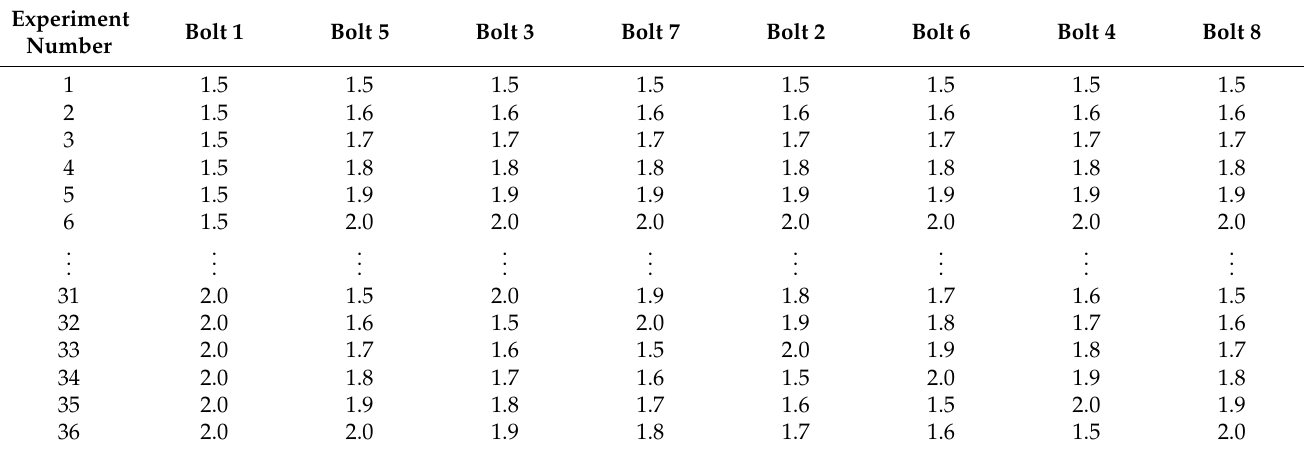
Table 2. Bolt tightening torque parameters (unit:N · m).